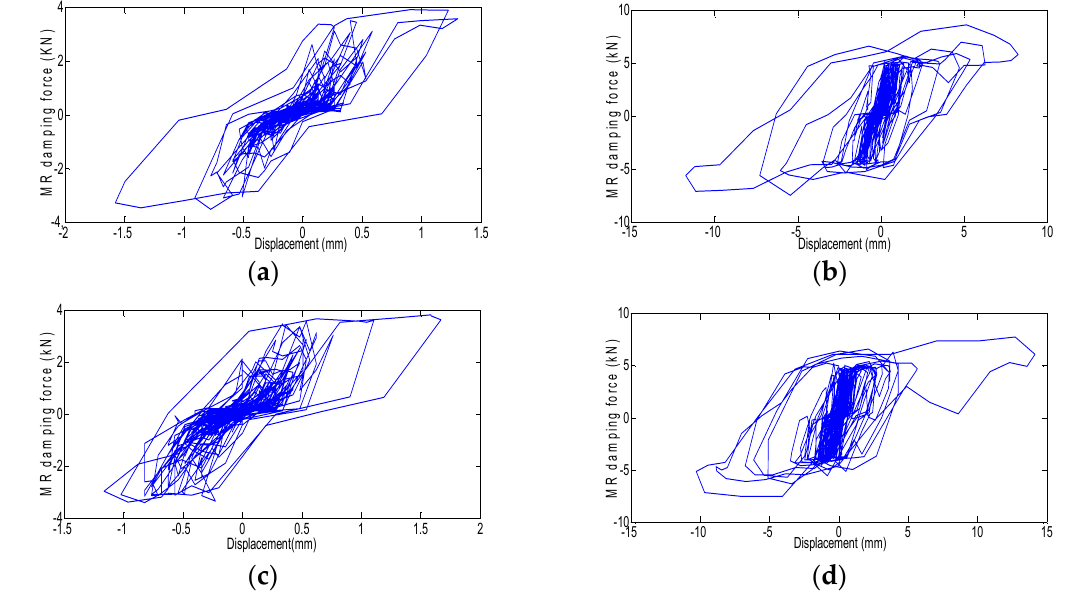
Figure 14. MR damper hysteretic curve. ( a ) El Centro earthquake—0.36 g; ( b ) El Centro earthquake—